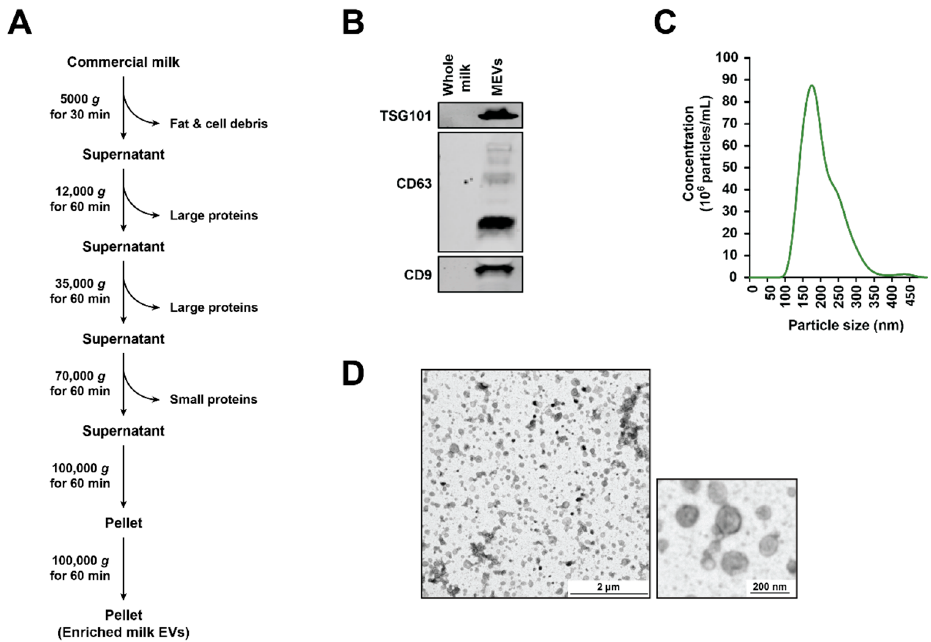
Figure 1. Characterization of milk-derived extracellular vesicles (MEVs). ( A ) Schematic diagram of ( B ) Western blotting analysis of 30 µ g of MEVs and whole milk probed with TSG101. ( C ) Nanoparticle tracking analysis of MEVs with the highest peak at 170 nm. ( D ) Transmission electron miscopy (TEM) images suggested the presence of vesicles in the